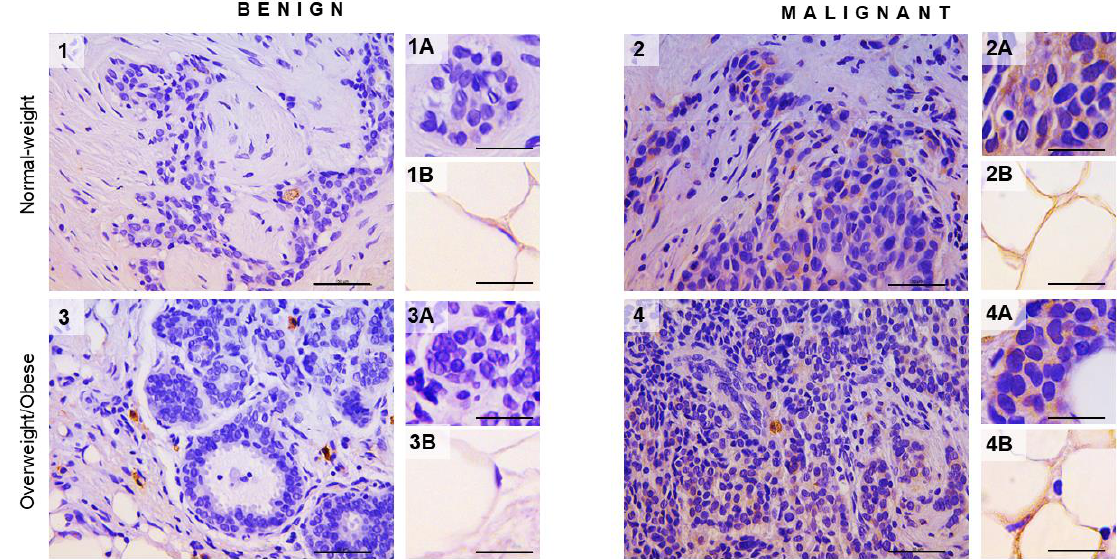
Figure 4. Hexokinase 2 expression in breast tumor and associated adipose tissue in normal-weight and overweight/obese premenopausal women. Immunohistochemistry and light microscopy showing hexokinase 2 protein localization patterns in benign (panels 1 and 3) and malignant (panels 2 and 4) tumor tissue. Cell-specific hexokinase 2 (brown staining) protein localization in breast epithelial cells (inserts 1A and 3A ) and adipocytes ( 1B and 3B ) in benign tumor tissues and breast cancer cells (inserts 2A and 4A ) and cancer-associated adipocytes ( 2B and 4B ) in malignant tumor tissues of normal-weight (panels 1 and 2) and overweight/obese (panels 3 and 4) premenopausal women. Magnification: ×40 and ×100, orig., respectively. Scale bars: 50 µm and 20 µm, respectively.